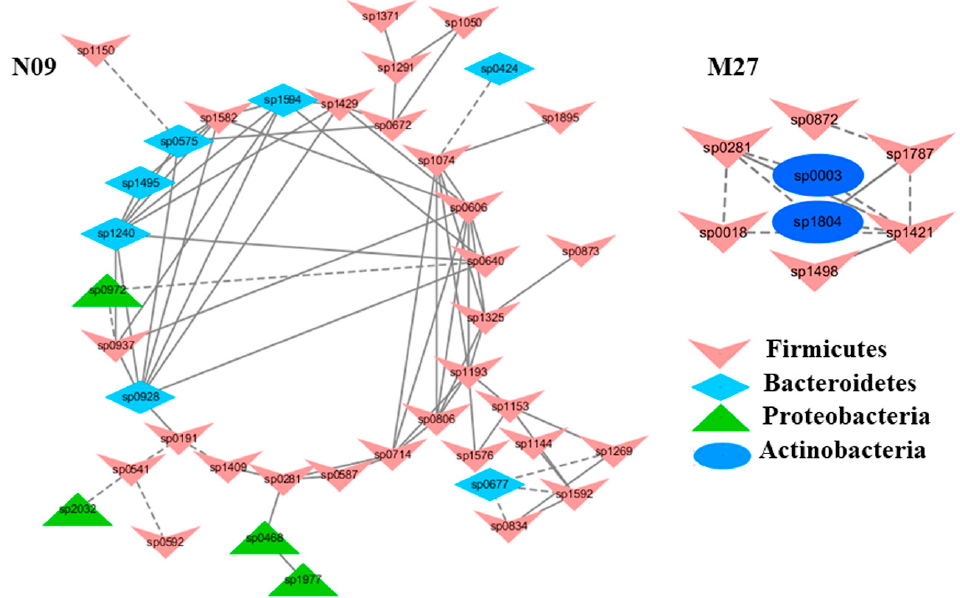
Figure 4. The modules in the mice subjected to exhaustive exercise stress (M) displaying a strong correlation with either blood urea nitrogen contents (BUN) (Module M03) or BUN to creatinine ratio (CR, Module M13) alone or both (Modules M02 and M21). The group N: healthy mice supplemented with PBS. The group M: mice subjected to exhaustive exercise stress supplemented with PBS. The group C: healthy mice supplemented with a daily dose of 150 mg/kg bodyweight of chondroitin sulfate disaccharide for 16 consecutive days. The group S: the stressed mice supplemented with a daily dose of 150 mg/kg bodyweight of CSD for 16 days. The detailed annotation of each OTU node can be found in Table S3.